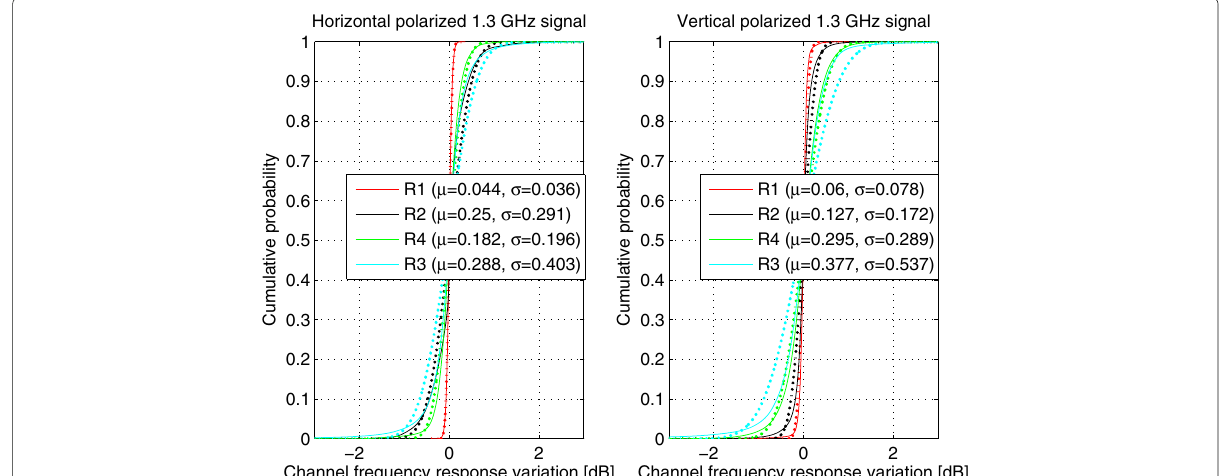
Fig. 14 Cumulative distribution function of channel frequency response variation of 1.3 GHz center frequency for both horizontal and vertical co-polarizations. The curve colored in red, black, blue, and green represent the calculated channel frequency response variation for the first to the fourth routes, respectively. The colored dotted lines represent the normal distribution of the corresponding measured channel frequency response variation values